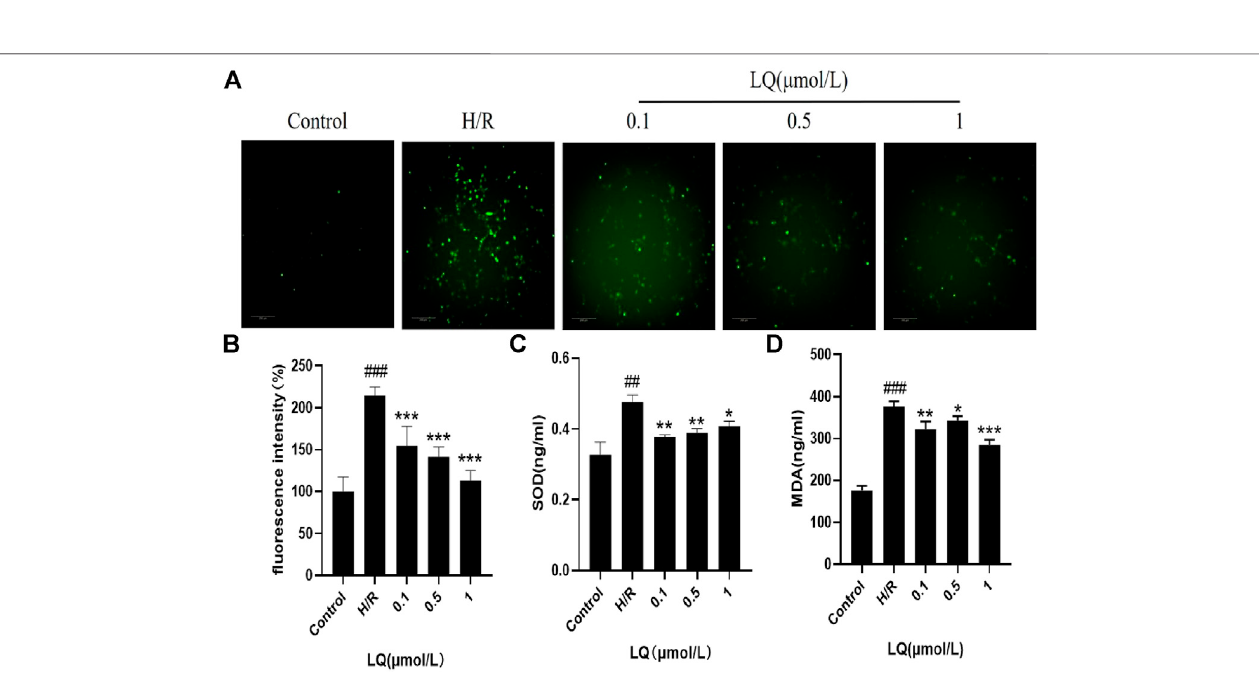
FIGURE5| LQregulatesROS,SODandMDAlevels. (A,B) Green fl uorescencerepresentsROS,comparedwithcontrol,green fl uorescenceintensityinH/Rgroup is enhanced, representing the increase of ROS level, and LQ can reduce ROS level. (C) SOD level was increased by H/R, and LQ reduced SOD level. (D) MDA level was increased by H/R, and LQ decreased MDA level. ## p < 0.01, ### p < 0.001, compared to control. * p < 0.05, ** p < 0.01, *** p < 0.001, compared to H/R.